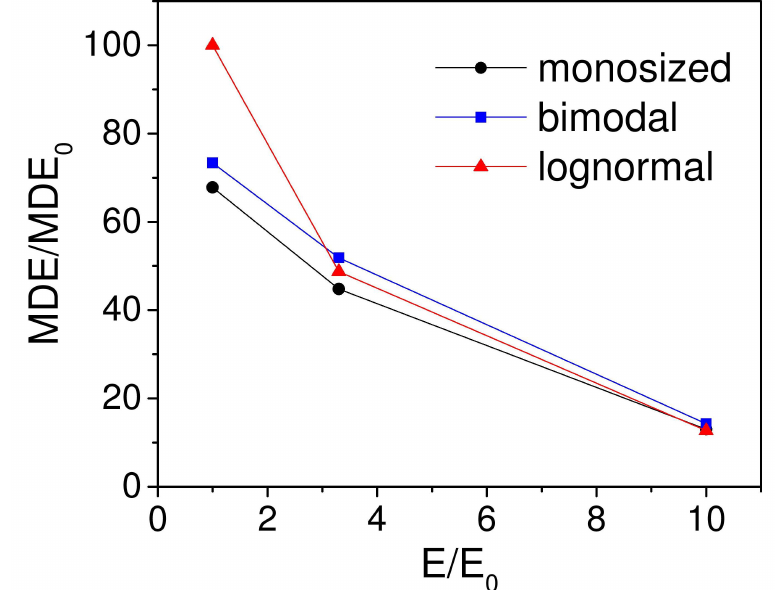
Figure 14. Decrease of MDE value with increase of Young’s modulus of the elastomer. MDE 0 is the value of MDE for average Young’s modulus E 0 = 0.01